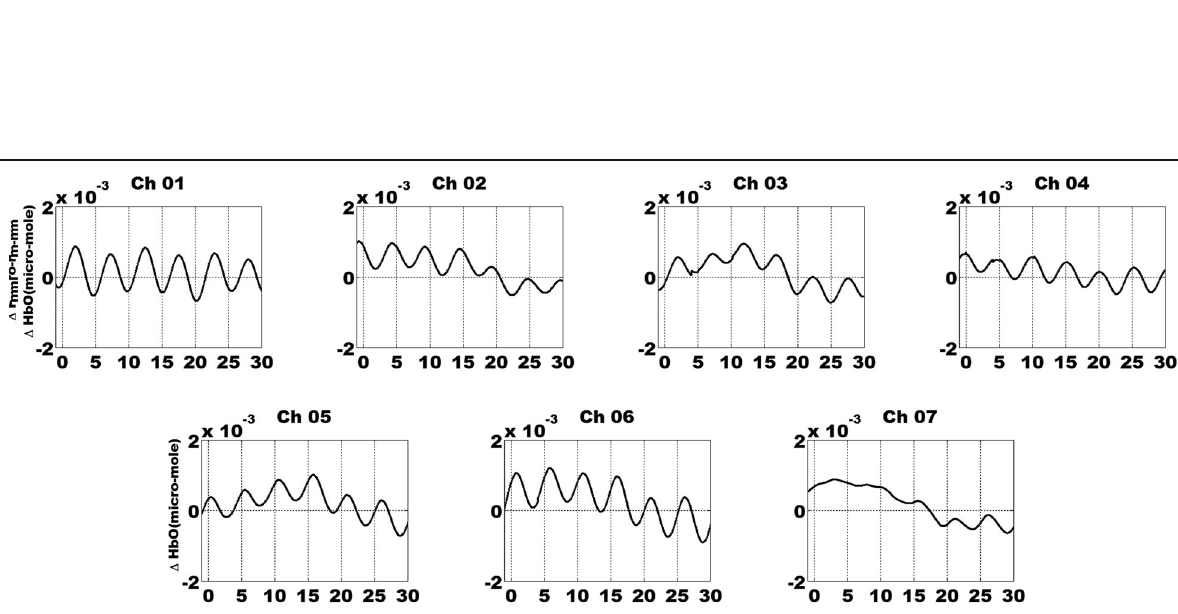
Fig. 3 The time-domain of HbO signals during periodic SSVEP-inducing FE stimuli presentation. The time course of fNIRS data is grand-averaged across all conditions and participants. The unit of the x -axis is seconds while the unit of the y -axis is